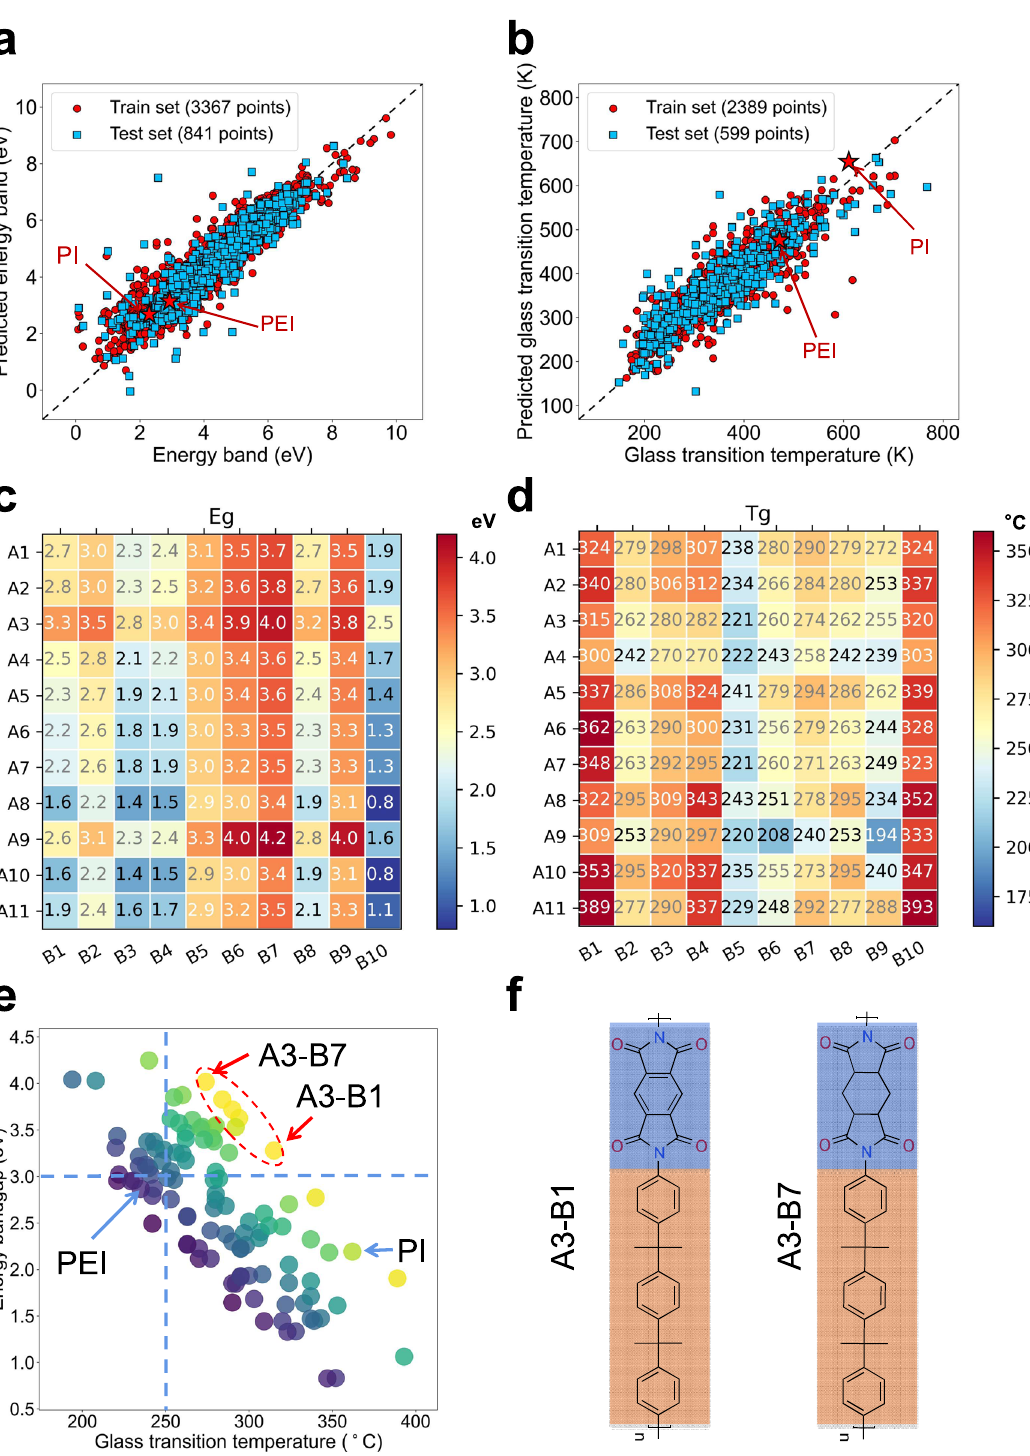
Fig. 2 | Prediction ofelectricaland thermal performance by machine learning. a, b The prediction results of the energy bandgap ( E g ) and glass transition tem- perature( T g )viaGPRlearningmethod. c,d The E g and T g frommachinelearningof the polymers composed by 11 × 10 monomers. e The scatterplot of T g versus E g